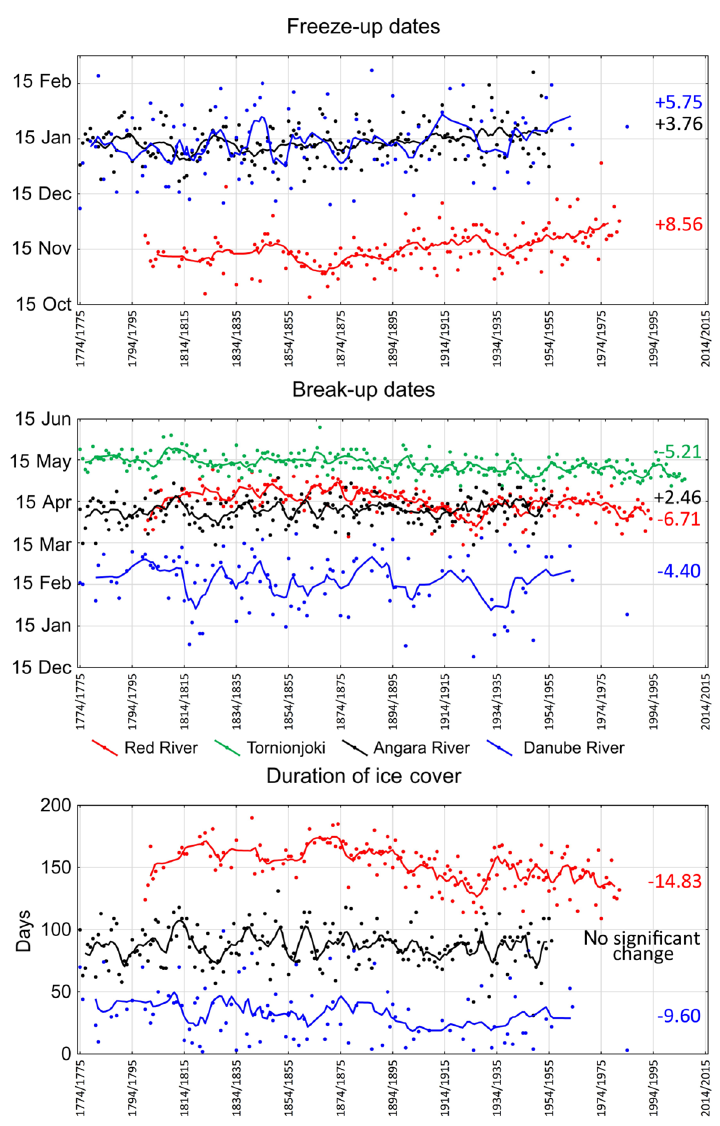
Figure 7. Variations in the dates of freeze-up and break-up on the Red, Tornionjoki, and Angara rivers and the River Danube for 1774–2017. (Data were smoothed using 10-year moving averages. Trend magnitudes are expressed in days/100 years and are marked with the same